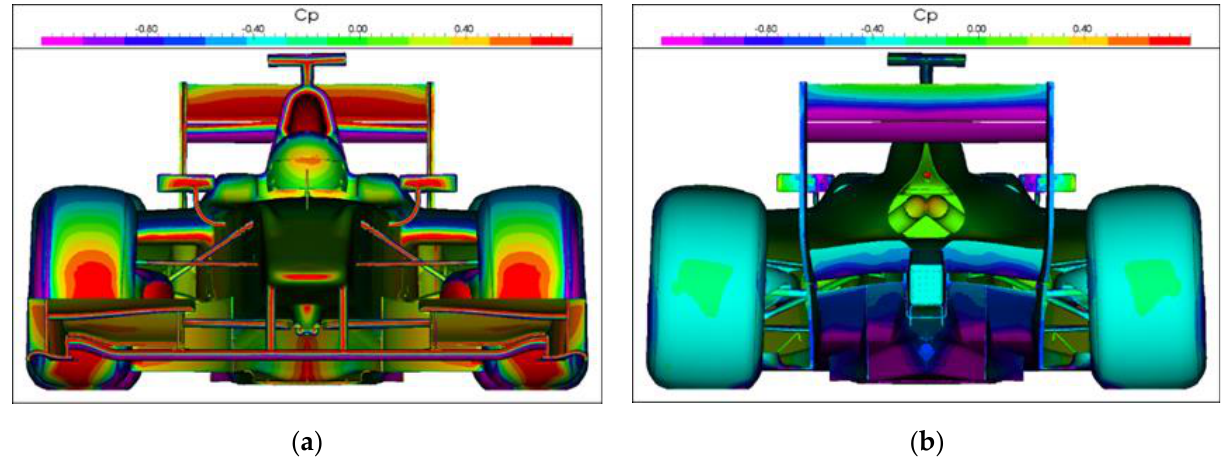
Figure 4. Pressure coefficient Cp in front and rear view: ( a ) front view showing stagnation pressure areas; ( b ) rear view showing low pressure areas under rear wing and in underbody Venturi ducts.